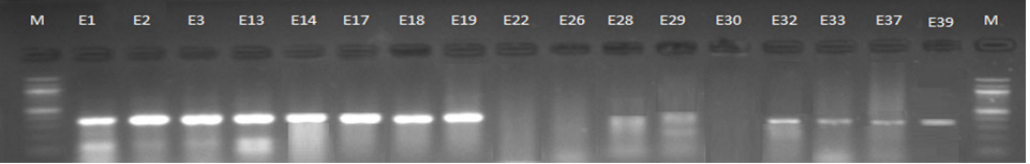
Fig. 3. 1.5% Agarose gel electrophoresis at 72 volt for 90 minutes of PCR to blaCTX-M-II amplicon (351bp); lane M represent DNA marker size(100bp) while E1-E39 represent the